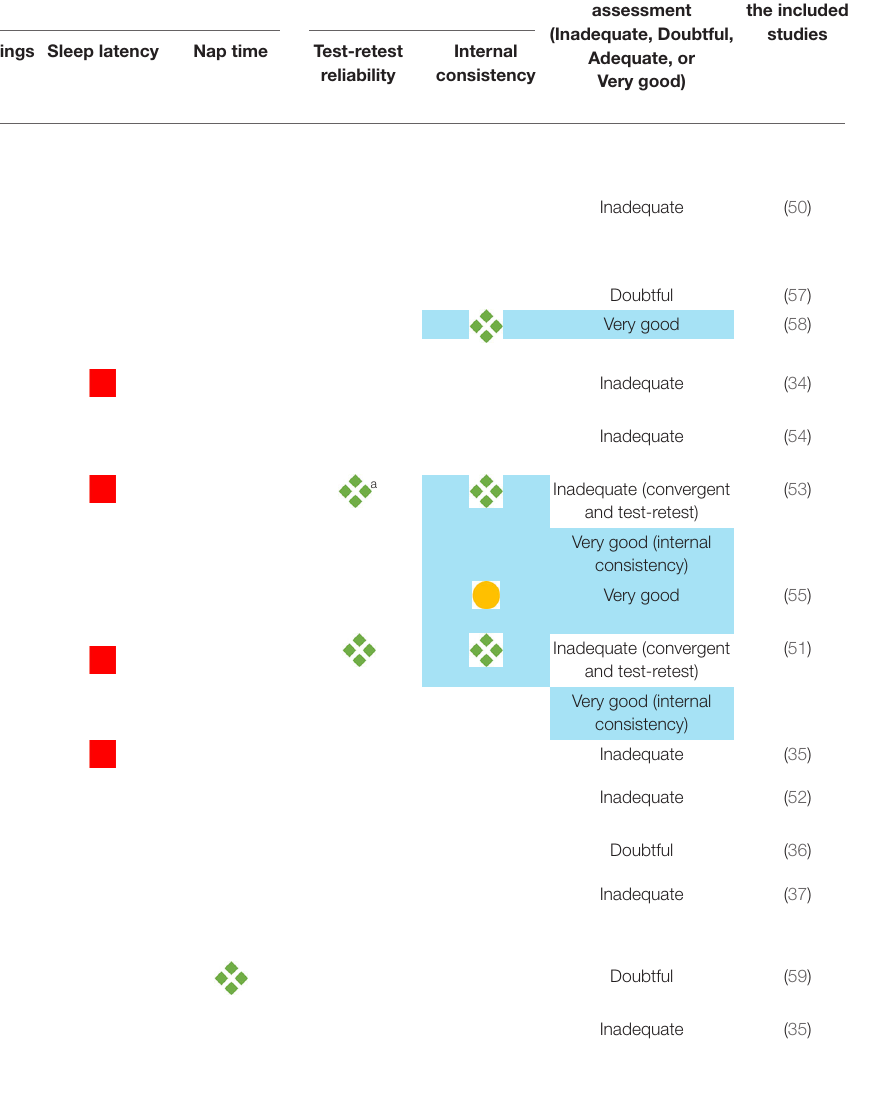
TABLE 4 | Summary table of the rating * of validity (criterion and convergent) and reliability (test-retest and internal consistency), and quality (risk of bias ** ), of the measurement tools for sleep parameters of pre-school aged children. Measurement instrument under study